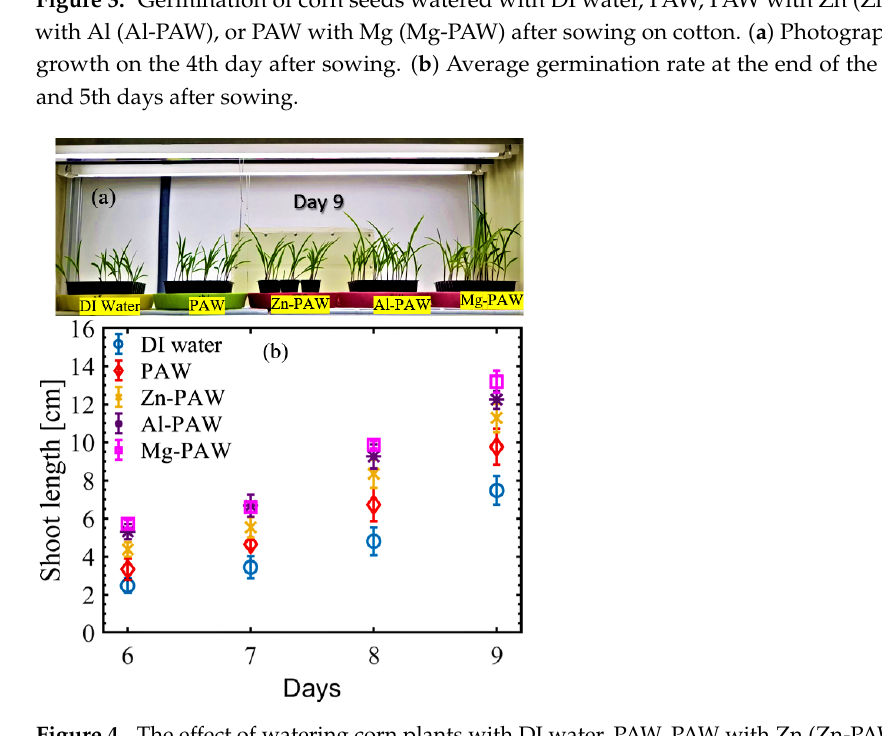
Figure 4. The effect of watering corn plants with DI water, PAW, PAW with Zn (Zn-PAW), PAW with Al (Al-PAW), and PAW with Mg (Mg-PAW). ( a ) Photograph of sample plants watered with various activated waters and the control treatment (DI water) depicting growth on the 9th day. ( b ) Average stem length (including leaf) on days 6, 7, 8, and